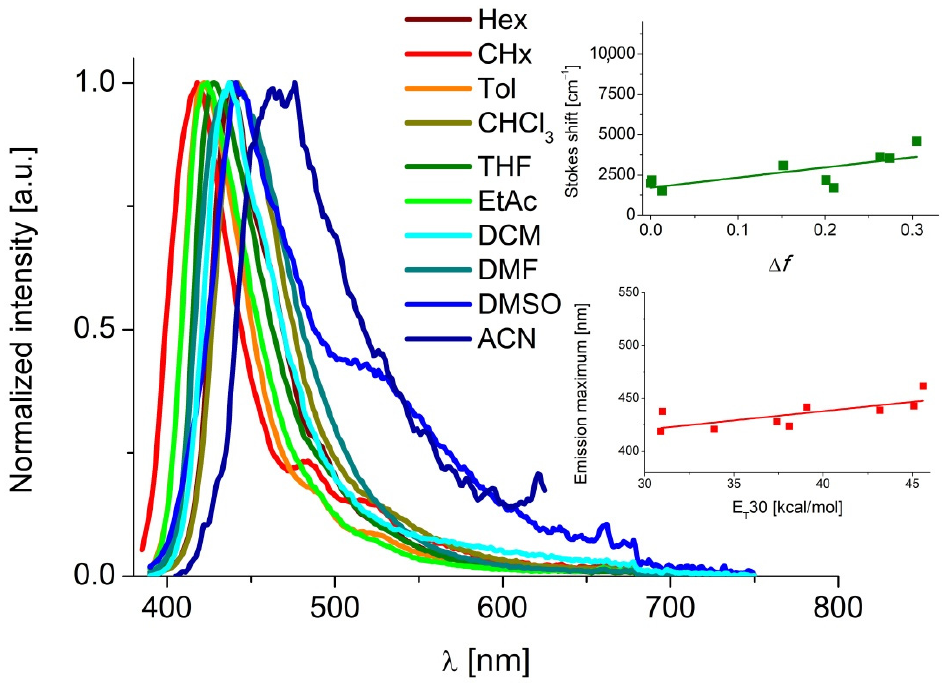
Figure 4. PL spectra of tBuTPAterpy in various solvents at 77 K (c = 10 µ M). Insets: Lippert—Mattaga plot of tBuTPAterpy (top); emission maximum vs Dimroth–Reichardt polarity parameter E T (30) for the employed solvents (bottom).